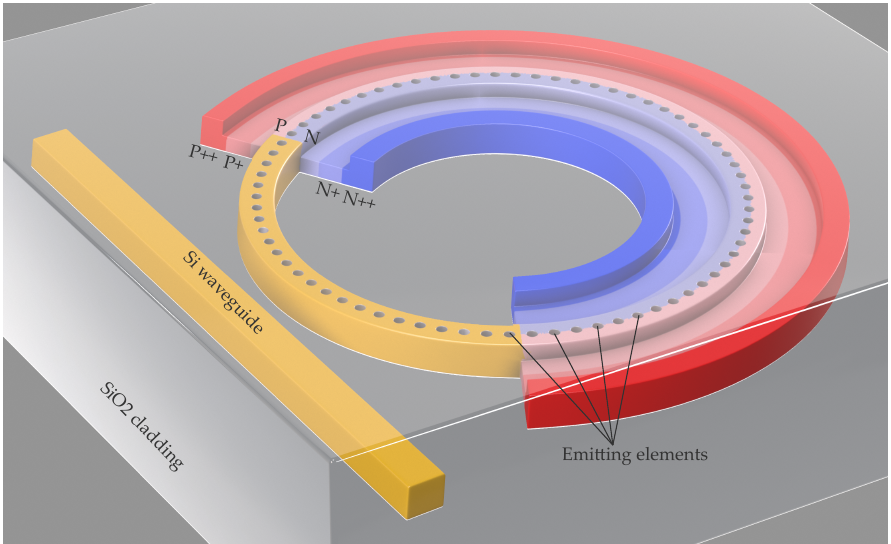
Figure 1. 3D view of the proposed device. The pn-depletion diode follows the Si rib bent waveg- uide. The different shades of blue and red represent the different electron (blue) and hole (red) concentrations where darker shades correspond to higher concentrations.